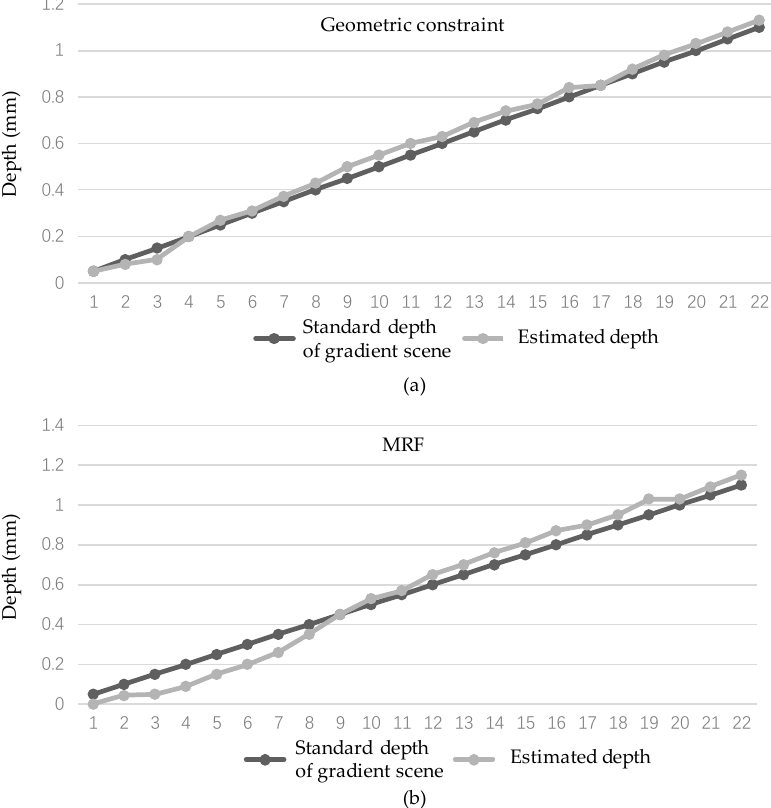
Figure 7. Gradient scene depth estimation quantitative comparison: ( a ) geometric constraint method; ( b ) MRF method.